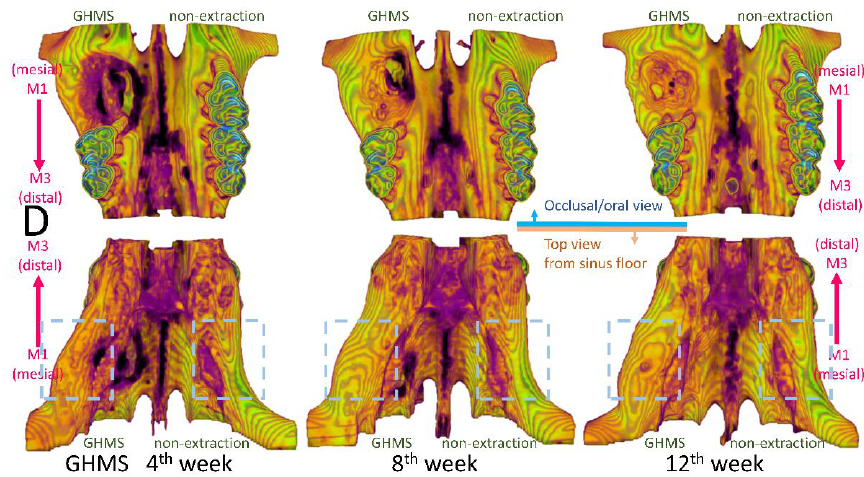
Figure 5. Representative three-dimensional micro-computed tomography (micro-CT) images of the maxillary first molar (M1) to third molar (M3) region of rats viewing from the occlusal/oral side and the top/sinus floor side after M1 ( A ) extraction or grafting with ( B ) Sinbone, ( C ) Bio-Oss Collagen ® , or ( D ) gelatin/nano-hydroxyapatite/metformin (GHMS) at the 4th, 8th, and 12th weeks.